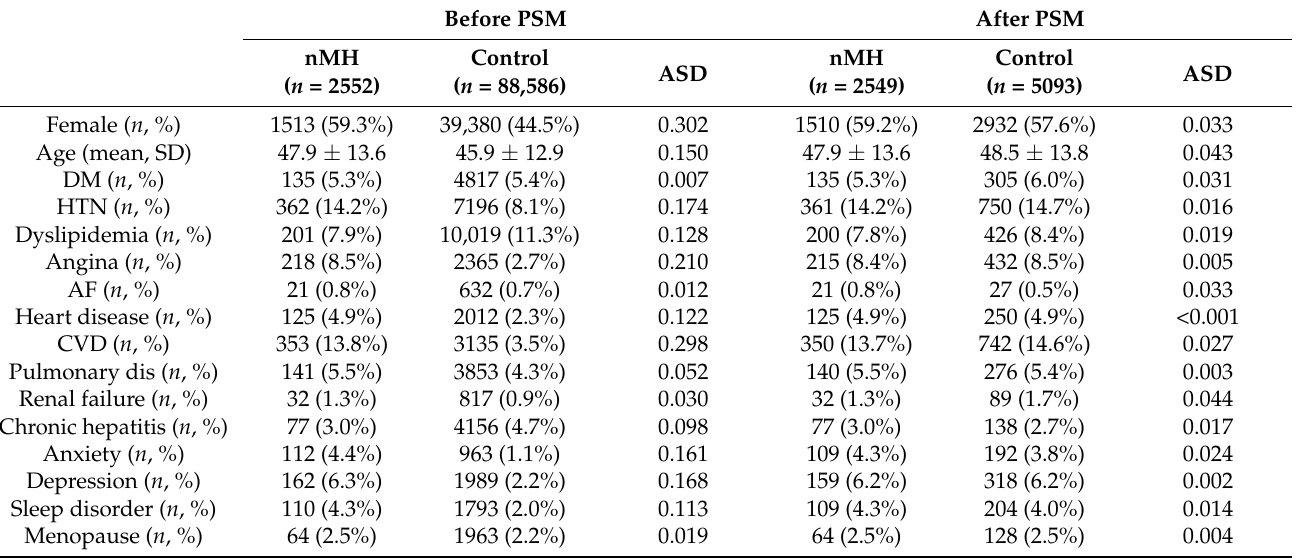
Table 2. Clinical characteristics of the non-migraine headache and control groups before and af- ter